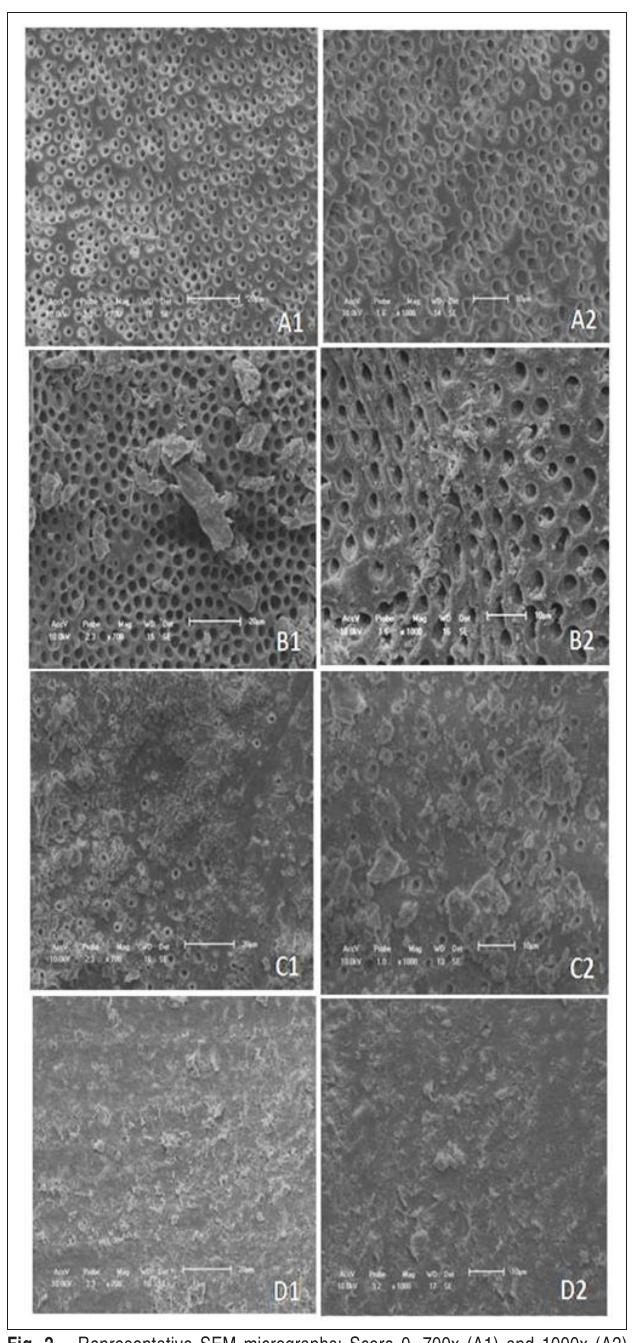
Fig. 2 – Representative SEM micrographs: Score 0, 700x (A1) and 1000x (A2) magnification; Score 1, 700x (B1) and 1000x (B2); Score 2, 700x (C1) and 1000x (C2); Score 3, 700x (D1) and 1000x